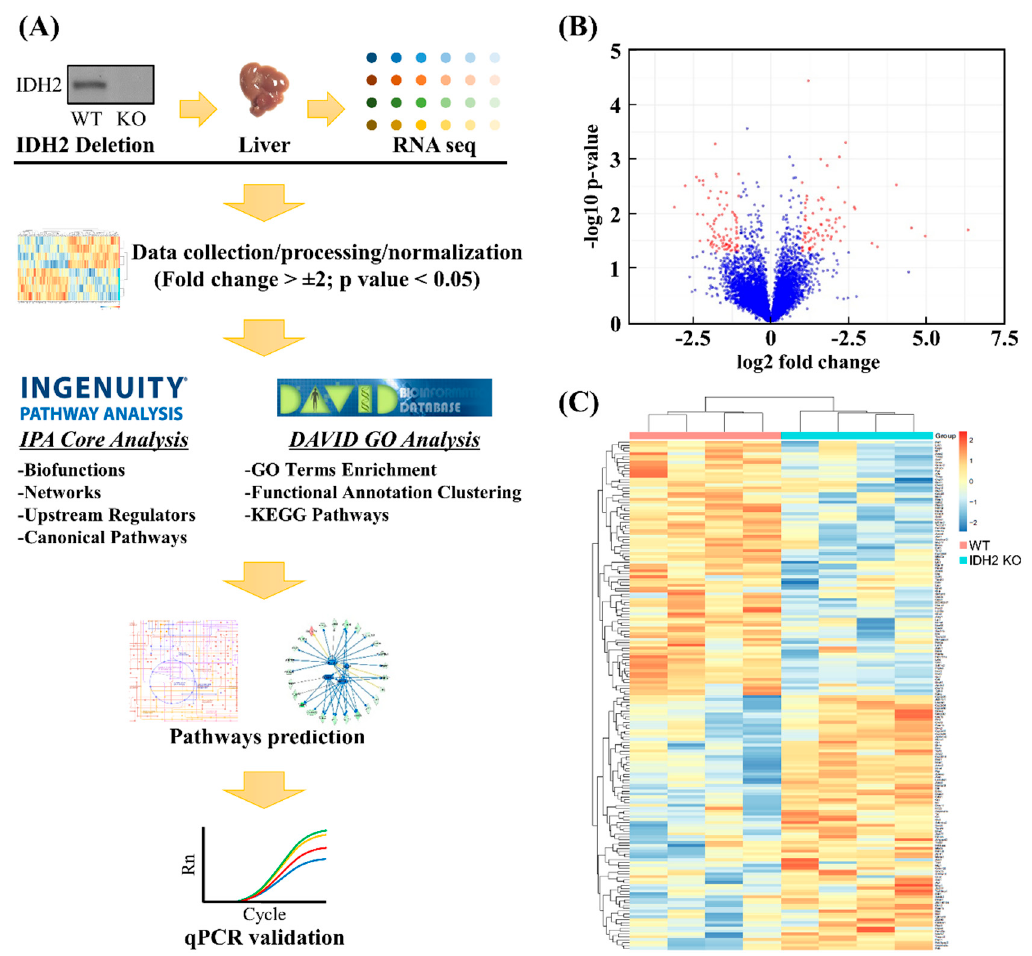
Figure 2. Procedures of hepatic transcriptomics dataset. The analyses of transcriptomics dataset followed by computational analyses and qPCR validation: A flowchart ( A ), A volcano plot ( B ), and heat map ( C ) showed differentially expressed genes and the relationships among samples used, respectively.